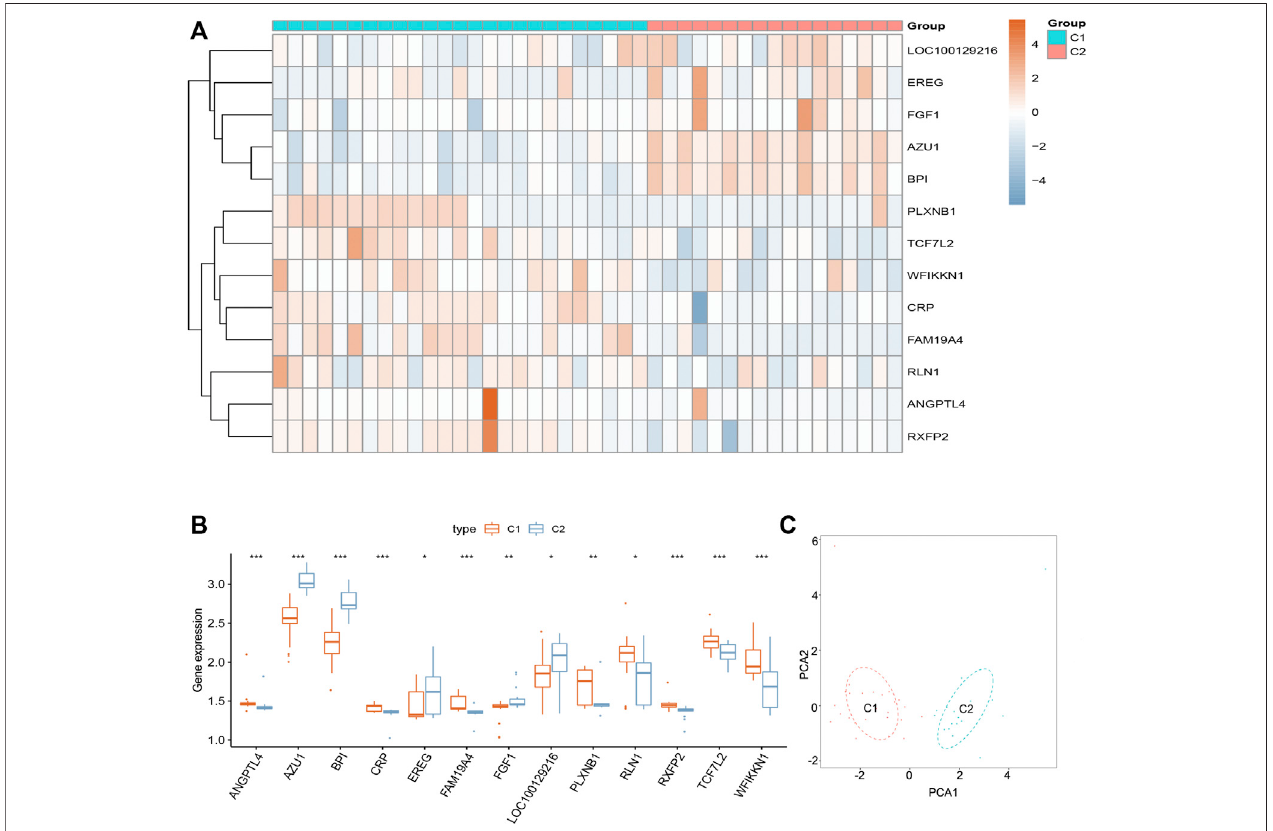
FIGURE6| LandscapeoftwosciaticasubgroupsintheGSE150408dataset. (A) Heatmapshowingtheexpressionof13DEIRGsbetweentheC1andC2groups in the GSE150408 dataset. (B) Histogram showing the expression of 13 DEIRGs between the C1 and C2 groups in the GSE150408 dataset. (C) PCA based on the expression of the 13 DEIRGs can distinguish between the C1 and C2